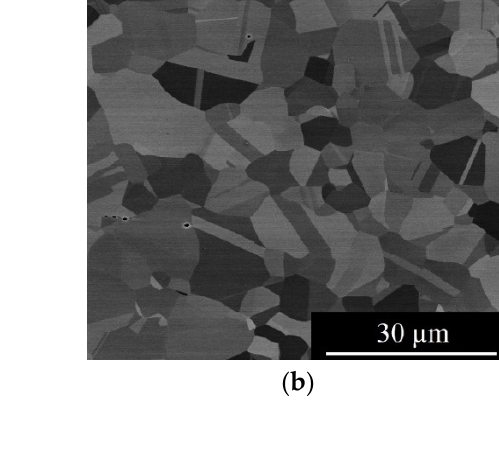
Figure 4. Microstructure of the N0 alloy after cold rolling and annealing at 700 °C ( a , c ) and 900 °C ( b , d ): SEM-BSE images—( a , b ), EBSD phase maps—( c , d ).